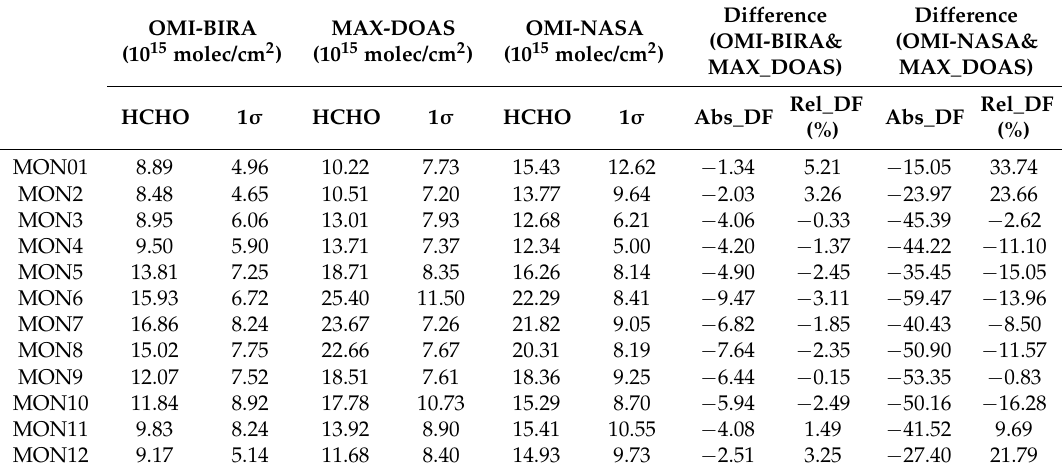
Figure 5. Multi-year monthly averaged HCHO concentrations for OMI-BIRA, MAX-DOAS and OMI-NASA. Table 1. Absolute and relative differences between OMI-BIRA, OMI-NASA and MAX-DOAS based on multi-year averages.